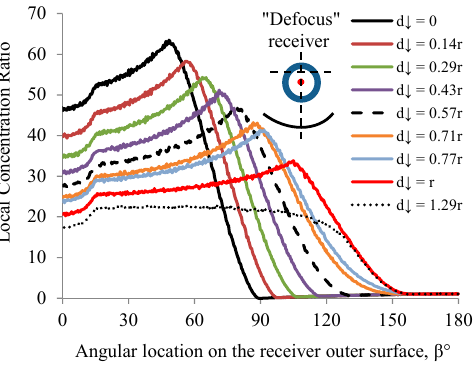
Ratio of dislocation of the receiver, d, and the radius, r, of the receiver.